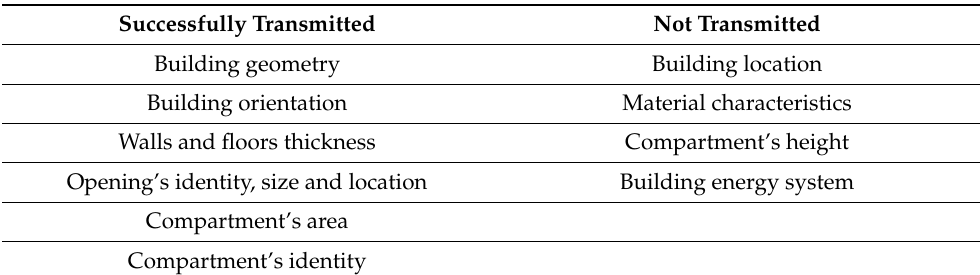
Table 3. Interoperability